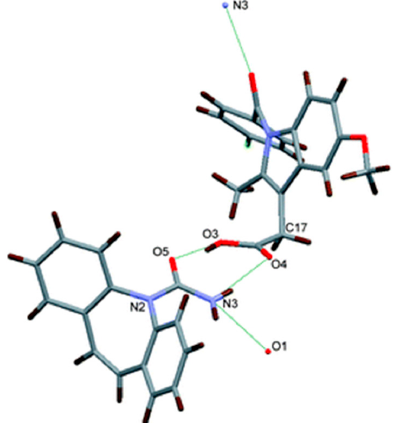
Figure 17. Acid-amide dimer synthon present in carbamazepine-indomethacin cocrystal obtained using PXRD structure solution. Adapted with permission from CrystEngComm , 2011, 13, 6327–6328. Copyright 2011, The Royal Society of Chemistry.